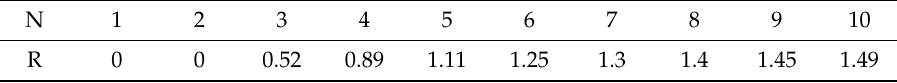
Table 9. The order of the matrix (N) and the equivalent random index (R).